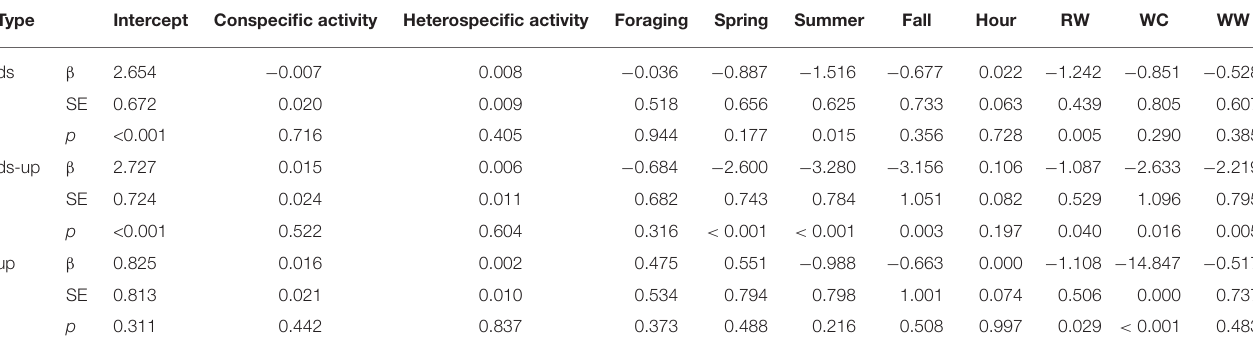
TABLE 7 | Multinomial logistic regression results for the effect of hourly conspecific activity, hourly heterospecifics activity, foraging, season, hour after sunset and site on social calling bout type for Nycticeius humeralis .